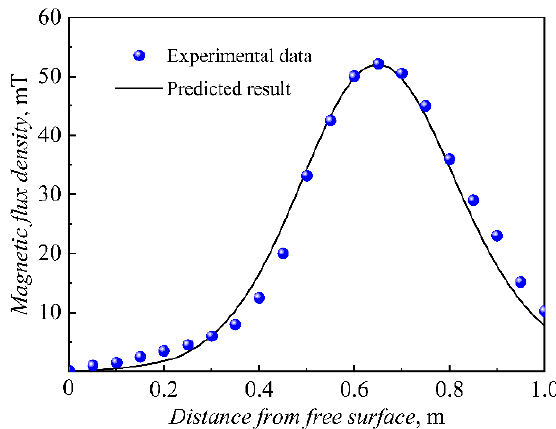
Figure 4. Magnetic flux density along the axis of bloom with M-EMS.